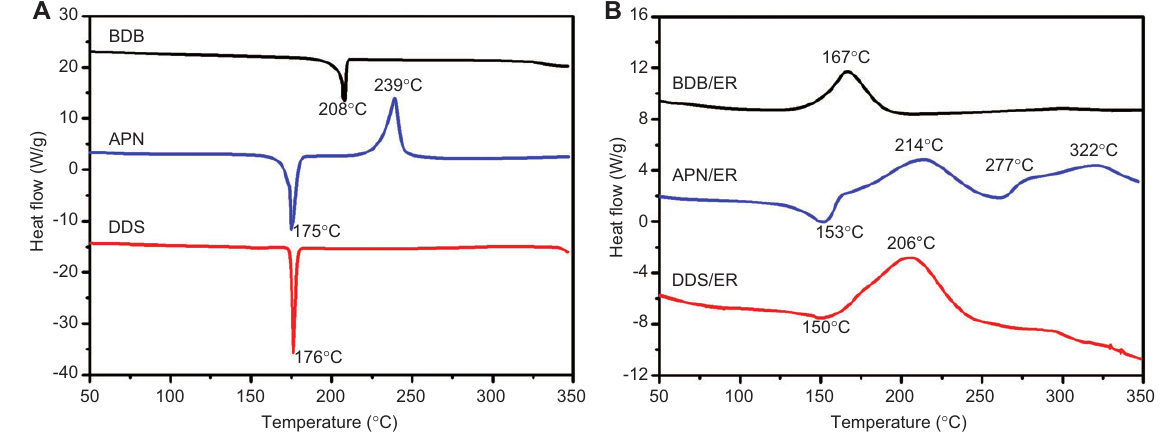
Figure 2 DSC curves of amines (A) and amine/epoxy blends